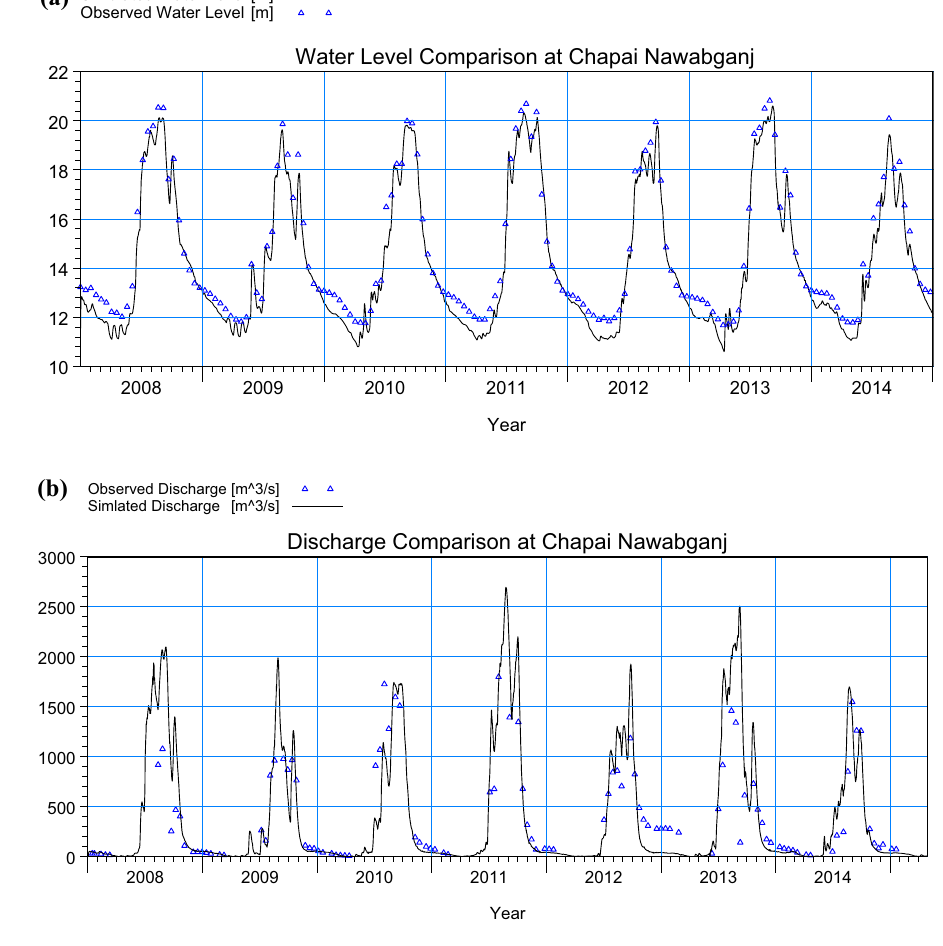
Fig. 6 The river model is cali- brated against both water level and discharge data obtained from Chapai Nawabganj station. The figure is showing a the water level calibration and b discharge calibration